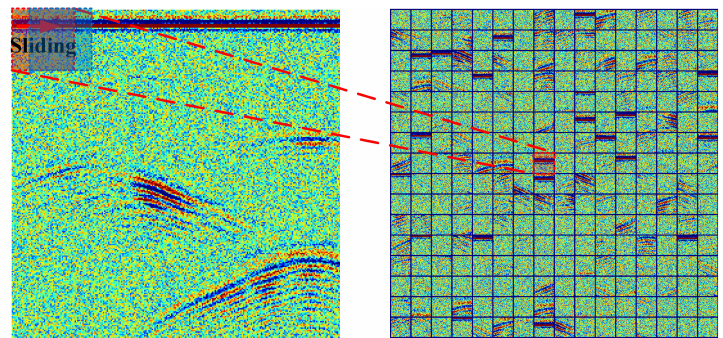
Figure 6. Sliding window process.